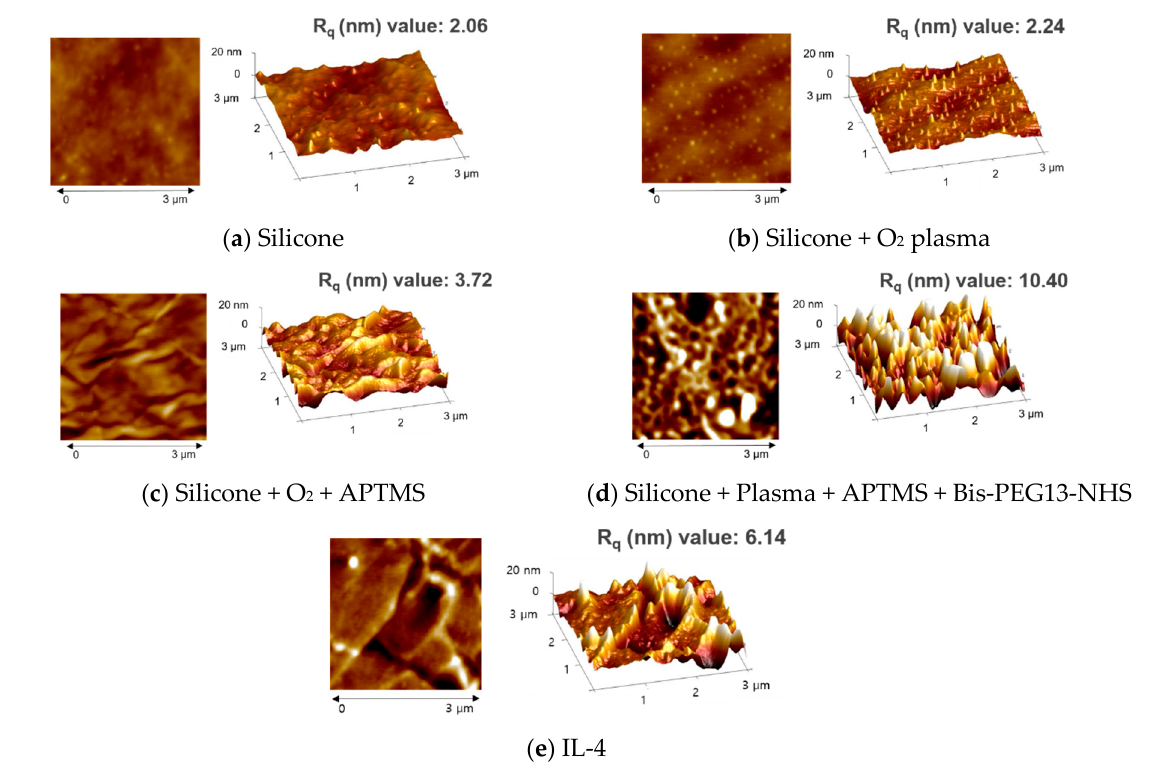
Figure 2. Surface morphologies of the silicone implants’ surfaces. The AFM images presented are surfaces of ( a ) a bare silicone implant, ( b ) O 2 plasma-treated silicone implant, ( c ) APTMS and O 2 plasma-treated silicone implant, ( d ) bis-dPEG ® 13 -NHS ester immobilization on ( c ), and ( e ) IL-4 immobilization on ( d ). Table 2. Water contact angle measurements of silicone breast implants.